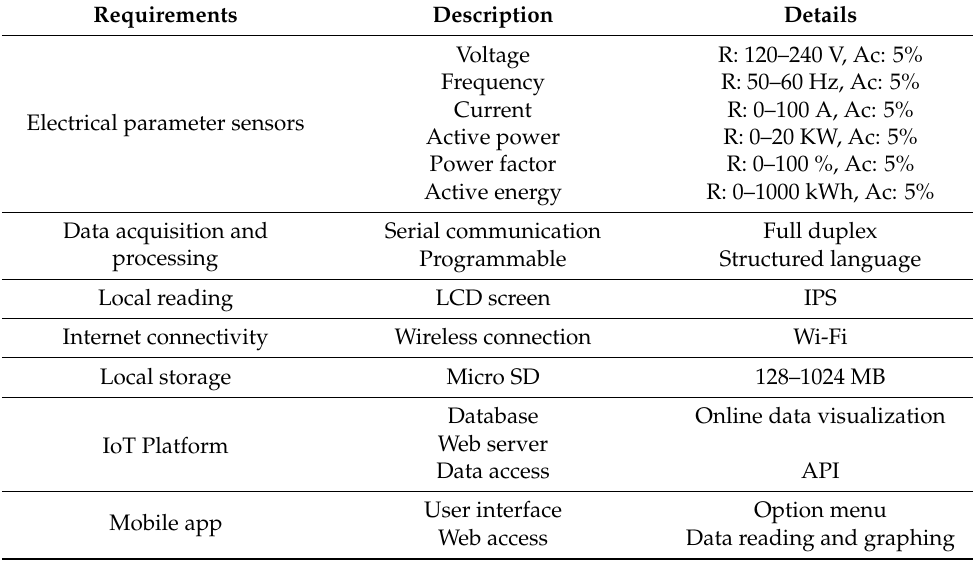
Table 1. Alternating current electrical parameter monitoring system